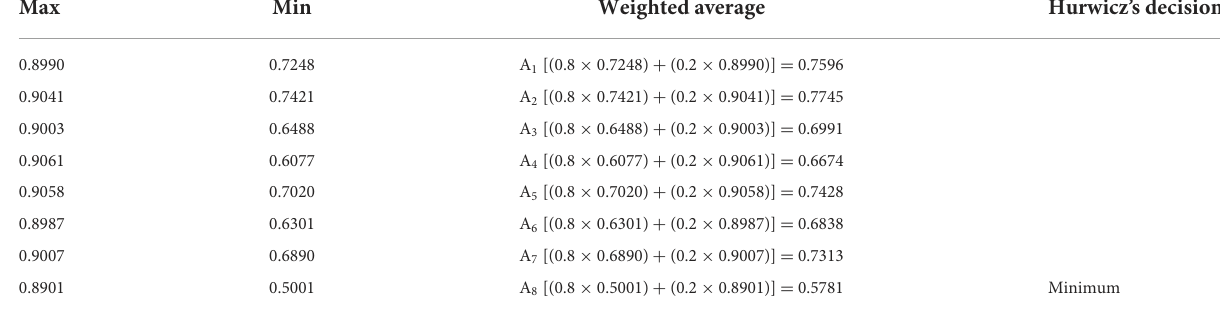
TABLE 4 Assessment based on the Hurwicz